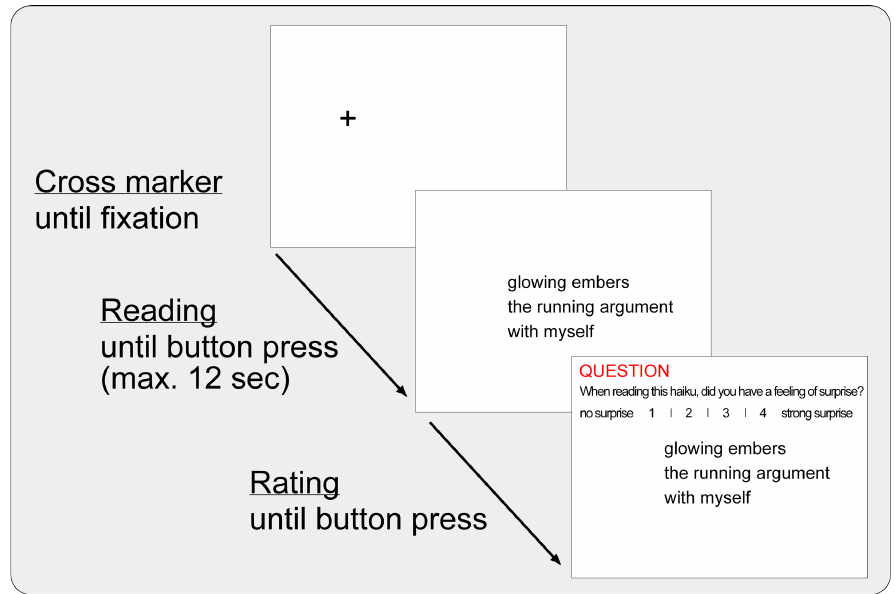
Figure 2 . Illustration of display screens with initial fixation-cross marker (screen 1), the haiku to be read (screen 2), and an example rating question following the reading (screen 3). The poem depicted is by Stella Pierides (Pierides,